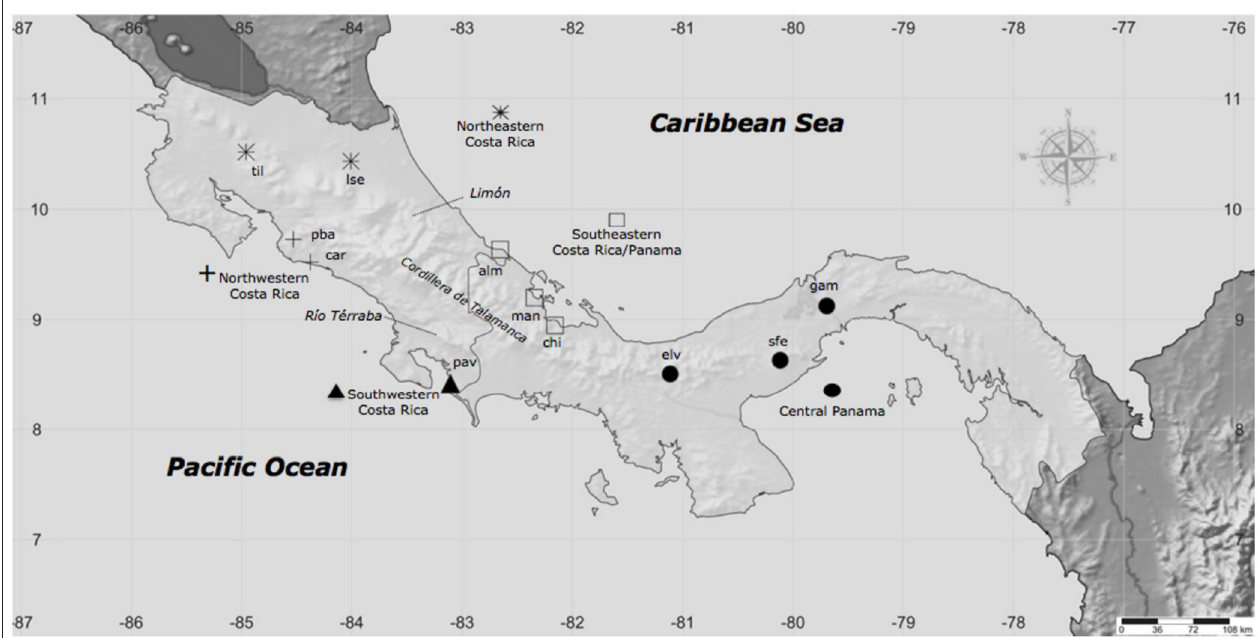
FIGURE 1 | Collection localities of A. callidryas skin secretion samples from 11 populations representing five biogeographic regions. At each locality we also sampled genetic tissue and took digital photographs for color analysis. See Table S1 for sample sizes.